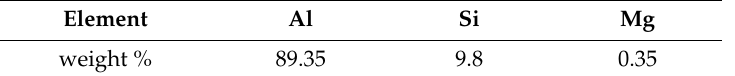
Table 1. The main compositions of AlSi10Mg spherical powder.